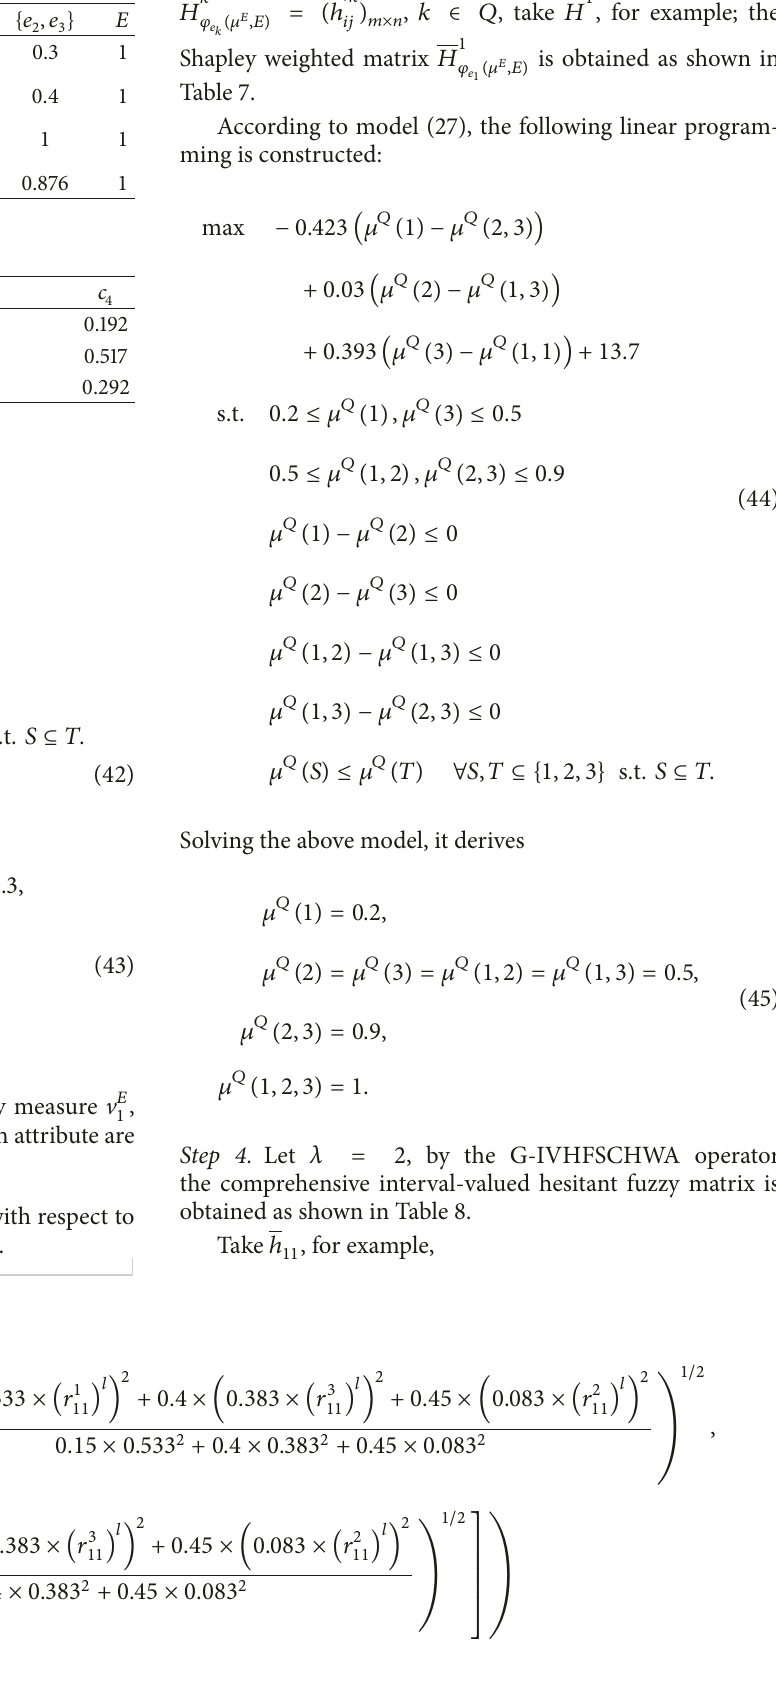
Table 5: The optimal fuzzy measures.